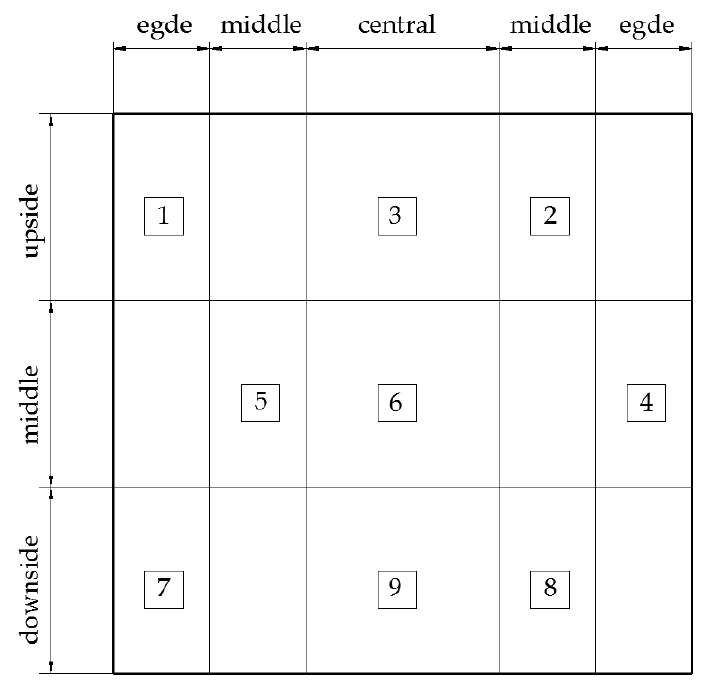
Figure 3. Strategy for obtaining the CCC sample.